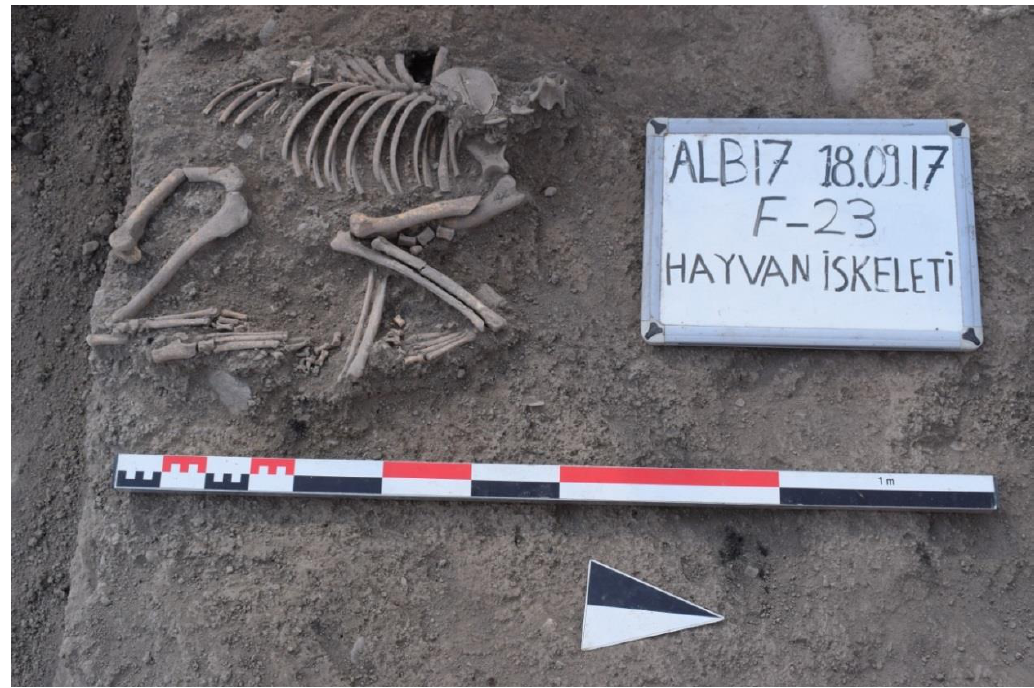
Figure 5. An in situ dog burial (ALB No. 1) unearthed from the empty space in the middle of the Iron Age workshop complex at Alaybeyi Höyük. Table 4. Distribution of the sex, height at withers, and body weight of the Alaybeyi dogs. Individual No.